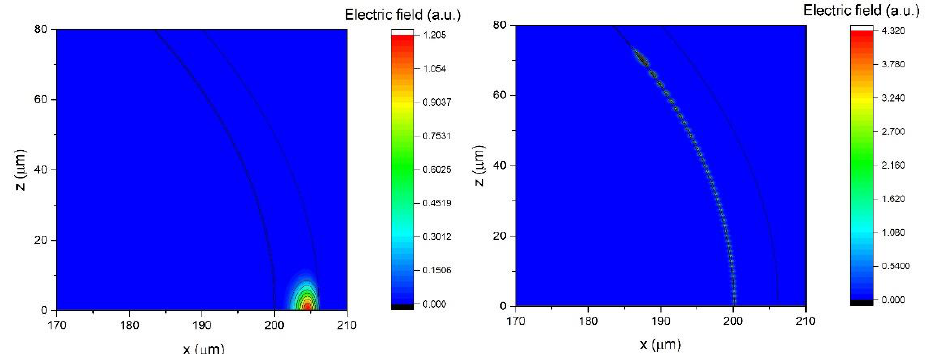
Figure 8. The electric field profiles for a 400 μ m sphere with d h = 200 nm and d = 6 μ m for the p = 1, l = m = 1156 mode ( left ) and the p = 0, l = 1239, m = 1156 mode ( right ). The origin x = z = 0 is in the center of the sphere. The z = 0 plane is the equatorial plane. The full lines represent boundaries between different layers.